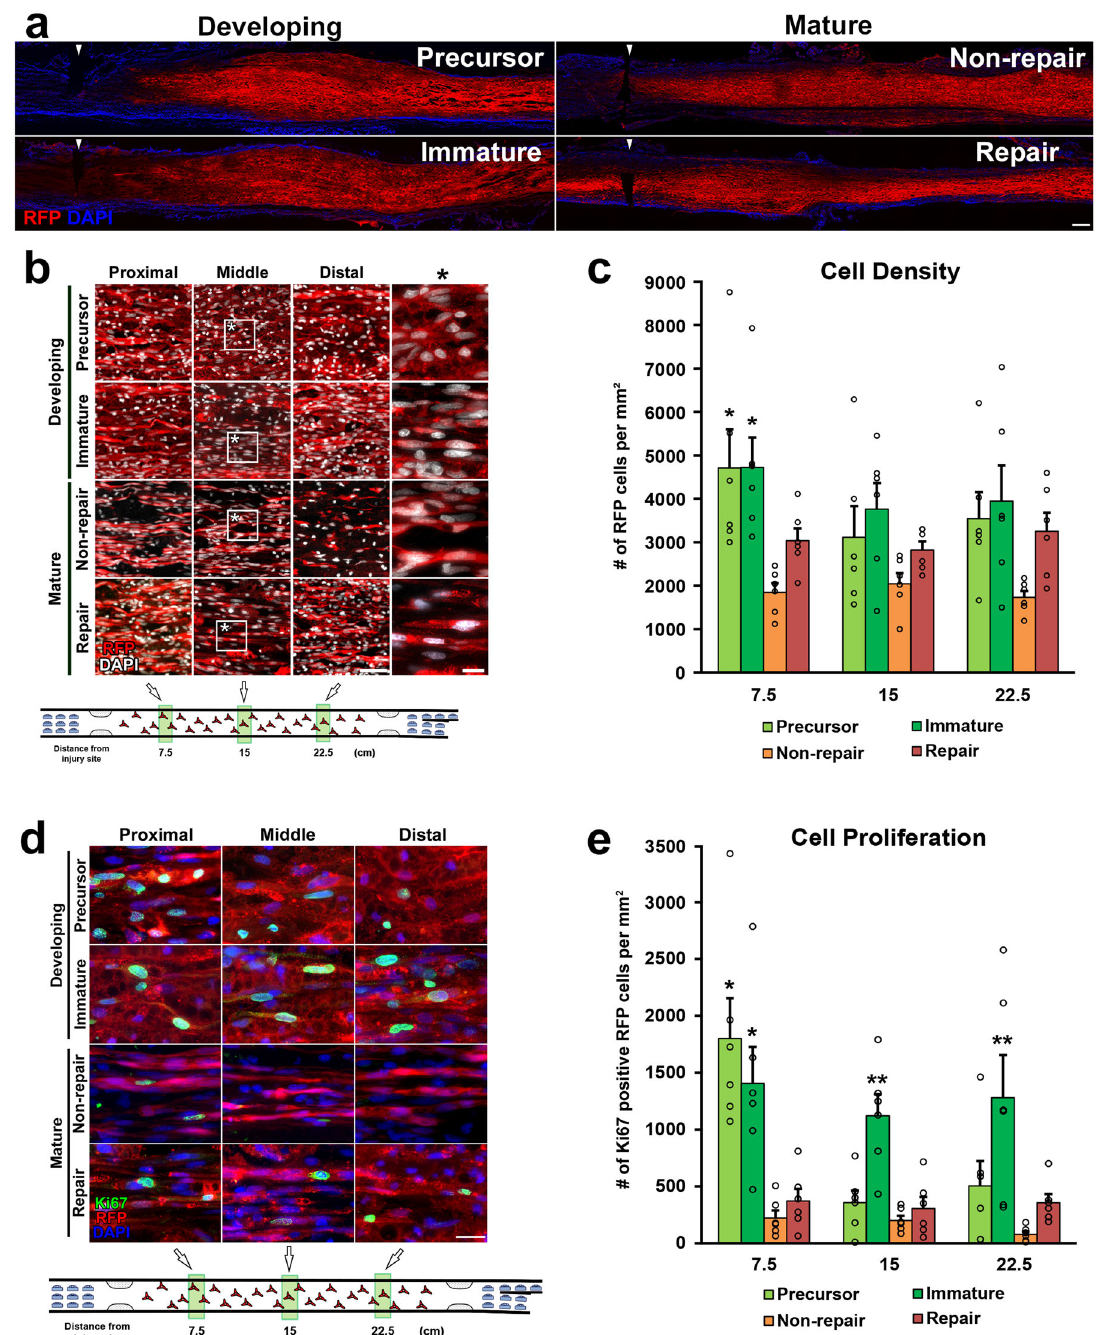
Fig. 2 Cell density and proliferative property of grafted SCs. a Low magni fi cation images of longitudinal sections around the proximal injury sites 2 weeks after SCs grafts. RFP expressing SCs of all types ful fi ll injured nerves. Arrowheads indicate the proximal injury sites marked by small cuts. Left is proximal. Scale bar, 500 µm. b RFP expressing grafted SCs at proximal, middle, and distal one-third of graft areas. Scale bar, 100 µm. *: High magni fi cation image of the boxed area. Scale bar, 10 µm. c Quanti fi cation of the density of grafted cells at 7.5, 15, and 22.5 mm points from the proximal injury site. At the 7.5 mm point, SCPs and ISCs graft subjects demonstrate statistically higher densities of RFP expressing cells than RSCs and non-RSCs subjects. Six rats per group. * P < 0.05 vs. n RSC and non-RSC, One-way ANOVA with the Tukey – Kramer test. Error bars represent the SEM. d High magni fi cation images of Ki67 immunolabeling at the proximal, middle, and distal one-third of graft areas. Scale bar, 20 µm. e Quanti fi cation of the density of Ki67 immunolabeled RFP expressing graft cells at 7.5, 15, and 22.5 mm points from the proximal injury site. Developing SCs have more proliferating than mature SCs after grafting. * P < 0.05 vs. non-RSC and RSC, ** P < 0.05 vs. other 3 groups. One-way ANOVA with the Tukey – Kramer test. Error bars represent the